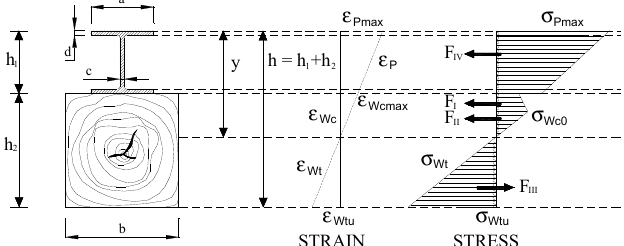
Figure 20. Reinforced timber beam cross section: stress and strain distribution, after timber yielding in compression. Reproduced from [58], with permission from Elsevier, 2007.